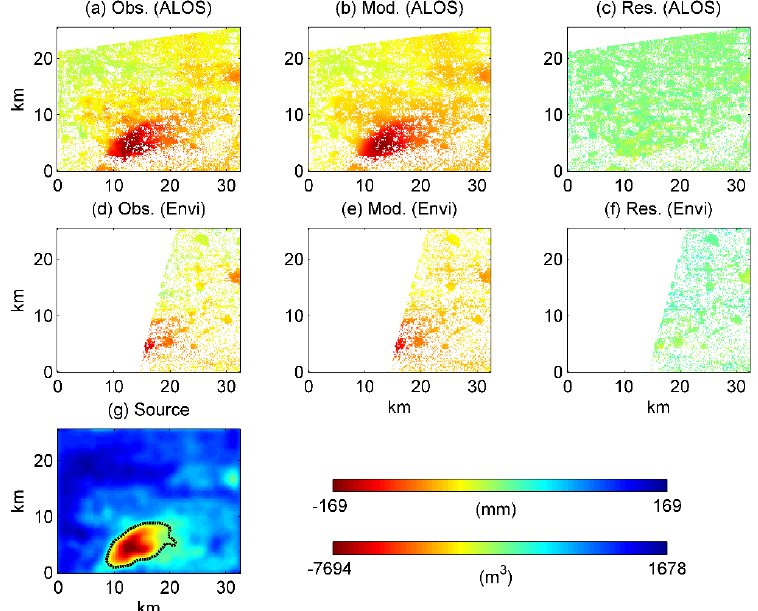
Figure 7. ( a ) ALOS LOS annual displacements (annual rates times one year); ( b ) modeled ALOS